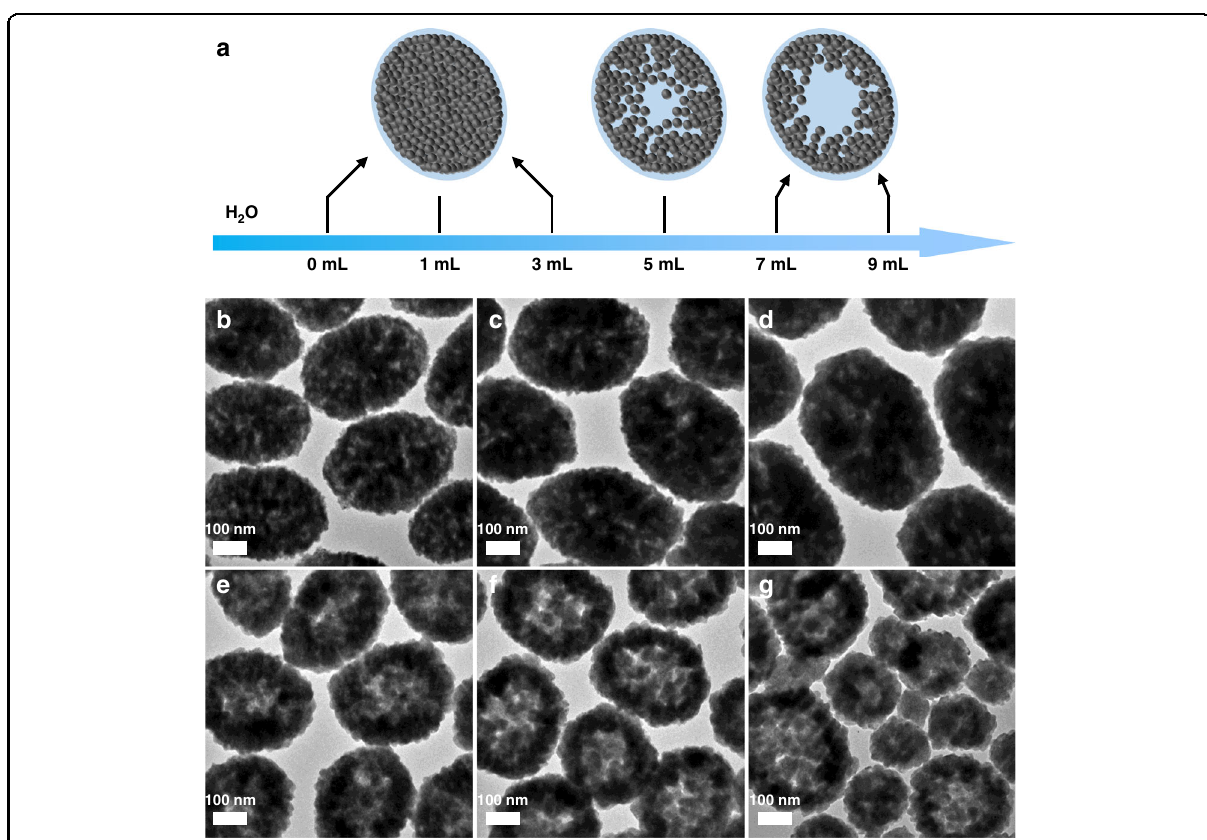
Fig. 3 Structural characterization of NBFYE nanoparticles synthesized by adding different amounts of H 2 O to the reaction system. a Schematic illustration of the morphology of nanoparticles varying with the amount of H 2 O. TEM images of NBFYE nanoparticles synthesized by adding different amounts of H 2 O to the reaction system in the presence of 1.5 g PAA. ( b ) 0 mL, ( c ) 1 mL, ( d ) 3 mL, ( e ) 5 mL, ( f ) 7 mL, and ( g ) 9